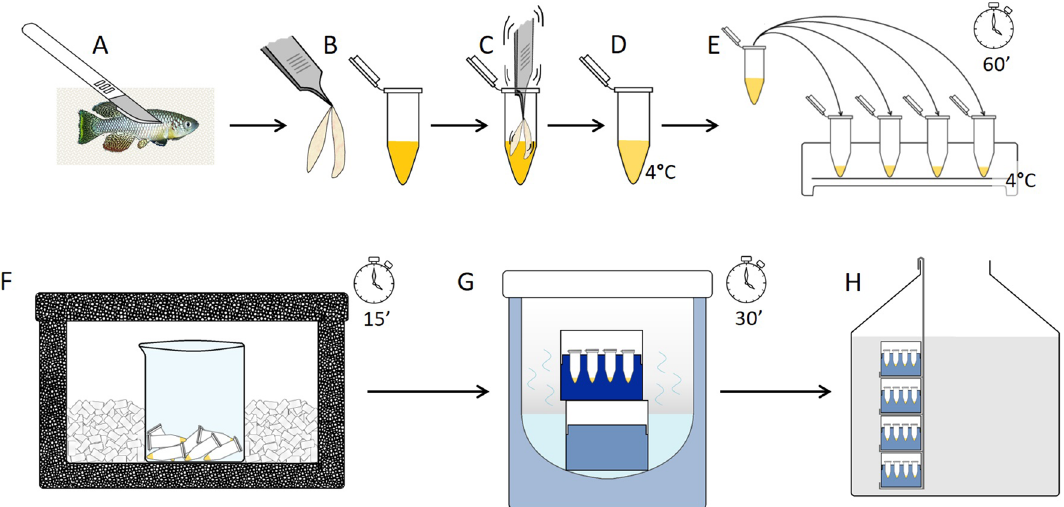
Figure 3. Schematic of sperm collection and freezing procedure. ( A ) Male dissection. ( B ) Gonad extraction. ( C ) Gonads are spun in extender plus cryoprotectant solution. ( D ) Cryoprotectant incubation with sperm cells at 4 °C. ( E ) Solution transfer in smaller aliquots to vials. ( F ) First freezing step setup with vials laying on the bottom of a glass beaker surrounded by dry ice in a closed styrofoam box. ( G ) Second freezing step setup with vials exposed to nitrogen vapor. ( H ) Long term storage of vials in liquid nitrogen. For a detailed explanation, see